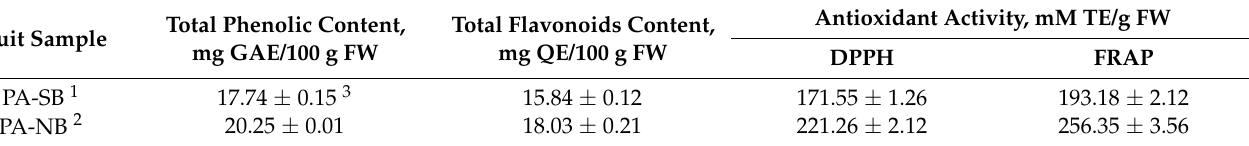
Table 6. Total phenolic and flavonoid content and antioxidant activity of acetone extracts from Physalis alkekengi fruit.